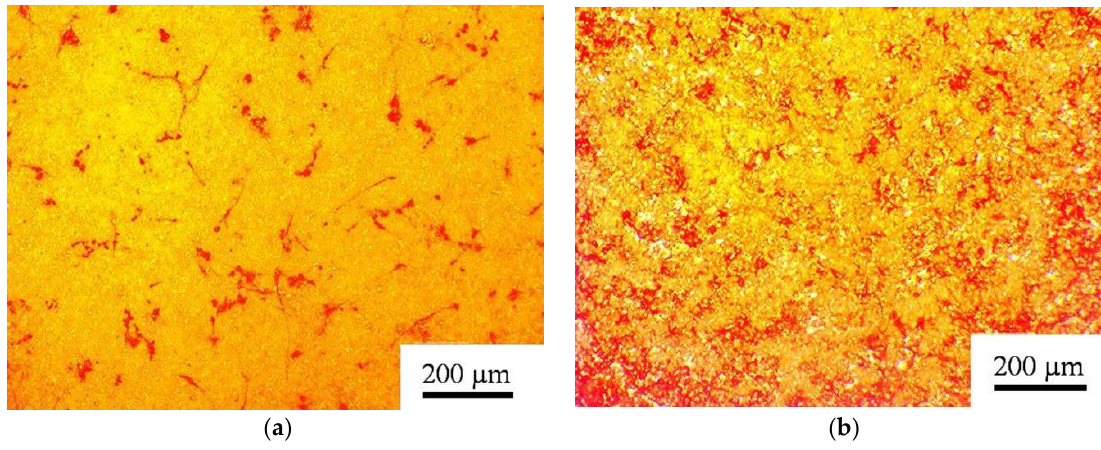
Figure 2. Human AMSCs cultured on a microarc calcium phosphate (CP) coating for 21 days in either ( a ) standard DMEM/F12 or ( b ) osteogenic differentiation media. Alizarin-red-stained areas of mineralized regions of the fibroblast-like cells and their intercellular matrix are shown.